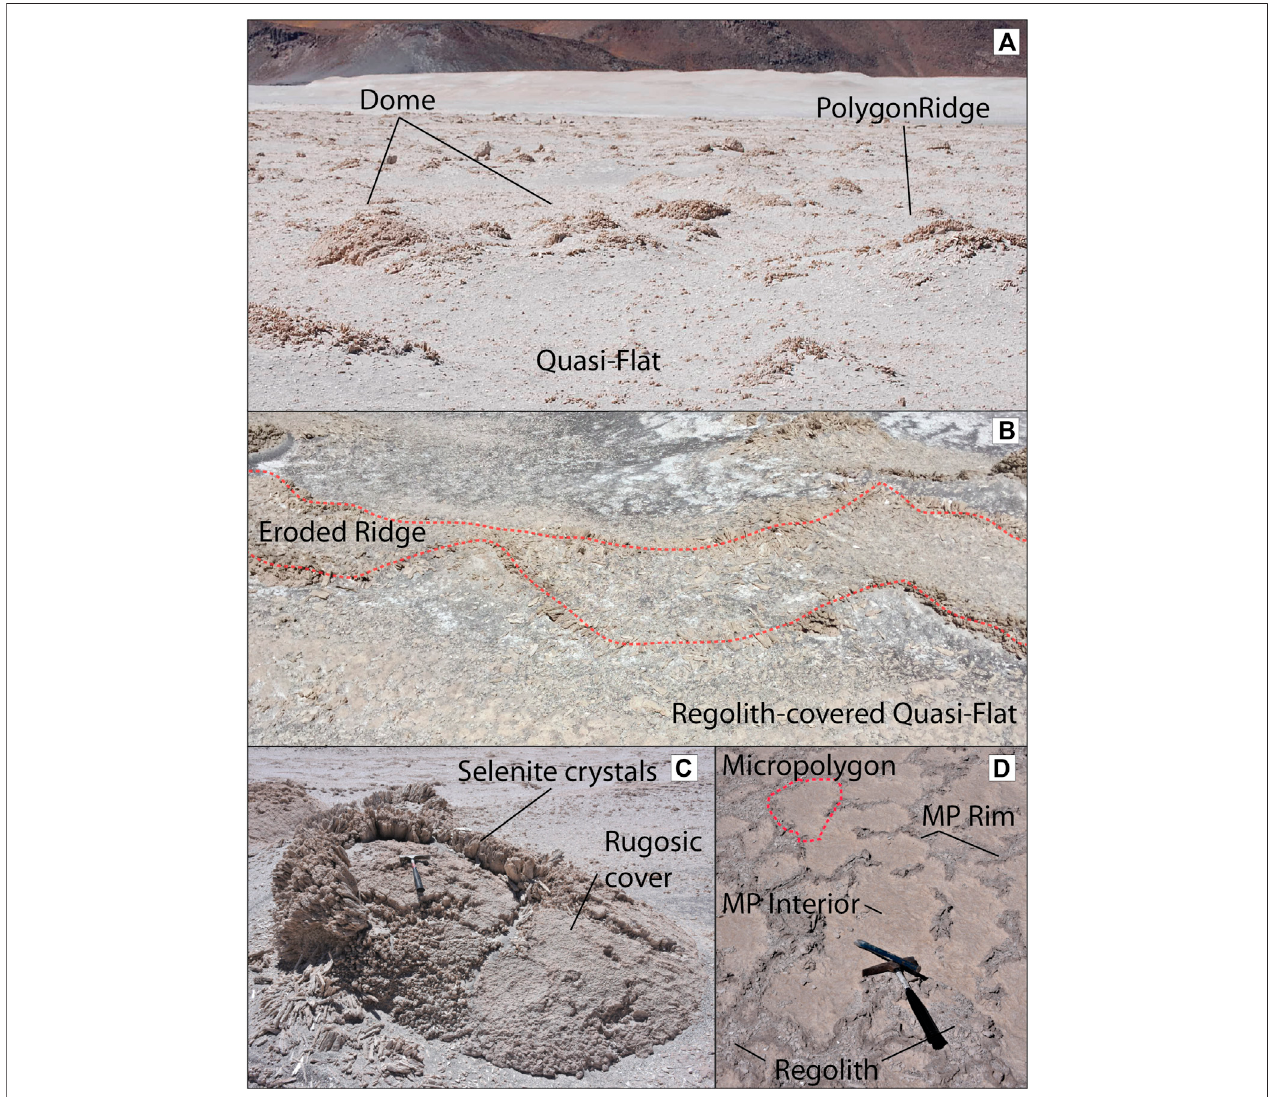
FIGURE3| MorphologiesofPolygonRidges,Domes,andQuasi-Flats. (A) LandscapeviewidentifyingPolygonRidges,Domes,andQuasi-Flats.Fieldofviewisca. 12 matthebottomedge. (B) GroundviewoferodedPolygonRidgeandregolith-coveredQuasi-Flat.Dashedredlinedelineateserodedridgemargins.Onridgemargins, selenite crystals are randomly oriented. Regolith occupies the space between the selenite crystals. Field of view is ca. 8 m. (C) Dome with rough surface and fractures. Roughsurfaces hadcombinationsofirregular micropolygonscomprisingMPInteriors, whichareirregular tileswithdiametersof10 – 30 cmthatareseparatedfrom each other by cracks or rims. MP Rims are narrow (3 – 5 cm) sinuous topographic highs ( < ca. 2 cm). Rough surfaces had a layer of duricrust and/or bulbous (i.e., platey, rugosic, or knobby) cover. Bothrough and smoothsurfaces(see3D)had fractures, which weresinuous,semi-continuous cracksthat werevertically displaceduptoca. 20 cm. Intact, growth-aligned crystals were visible on the upward-thrust side of the fractures. (D) Quasi-Flats with regolith, micropolygons, MP interiors, and MP Rims. MPinteriorscouldbebare,hard,smoothsurfaceswithselenitecrystalstruncatedacrossthegrowthplaneorcouldbecoveredwithregolith.MPRimsweregray/brown, cemented,sand-sizedor fi nermaterialpresentaselongate,positivetopographicfeatures.Thepro fi leofMPRimscomprisedacentral,grain- fi lled,cm-scale-deepfurrow and two parallel edges that thinned towards and blended into the MP